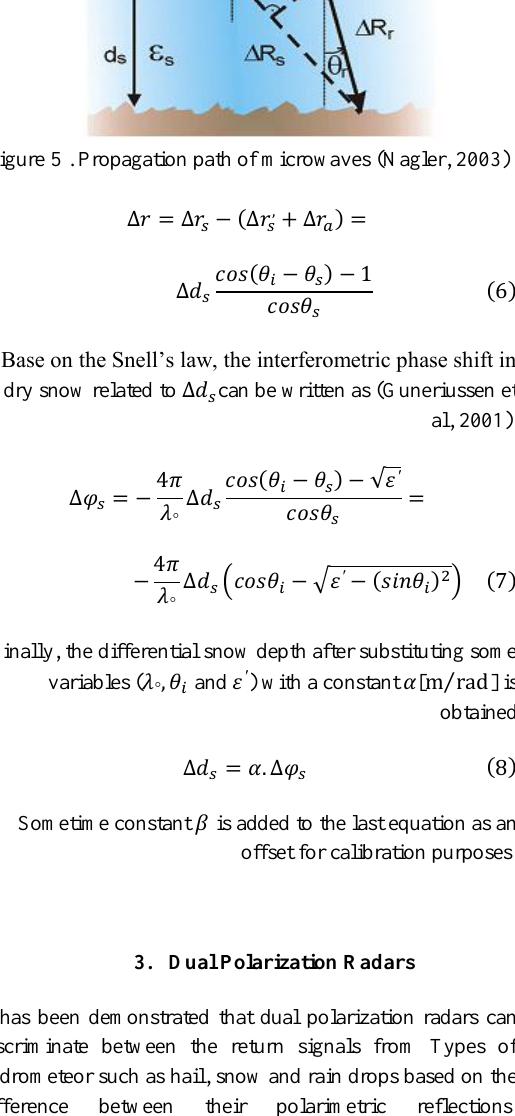
Figure 4 . Backscattering coefficients at Ku and L band (Saint-Martin et al, 2003)